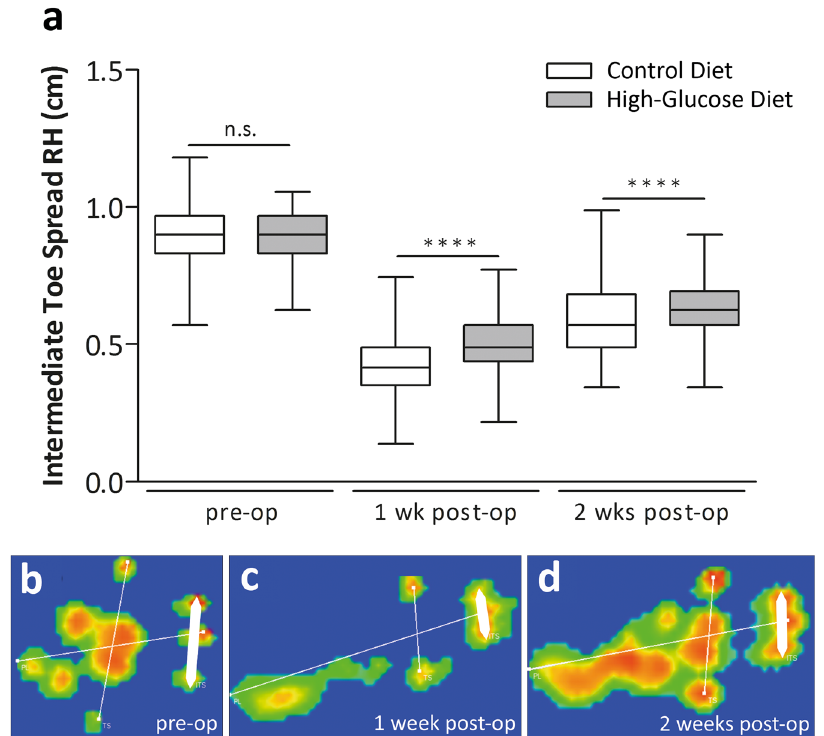
Figure 1. Gait Analysis: Intermediate toe spread (ITS). Intermediate toe spread (ITS) of the right hind limb (RH) before surgery was equal between the experimental groups ( a ). One week post-op, ITS was significantly higher in the high-glucose group compared to the control group (p < 0.0001; Mann-Whitney test, two-tailed). 2 weeks post-op, ITS remained significantly higher in the high-glucose group compared to the control diet group (p < 0.0001; Mann-Whitney test, two-tailed). Representative images for ITS measurements pre-op ( b , one week post-op ( c ) and 2 weeks post-op ( d ). ITS (thick white bar) represents the distance between second and fourth toe.